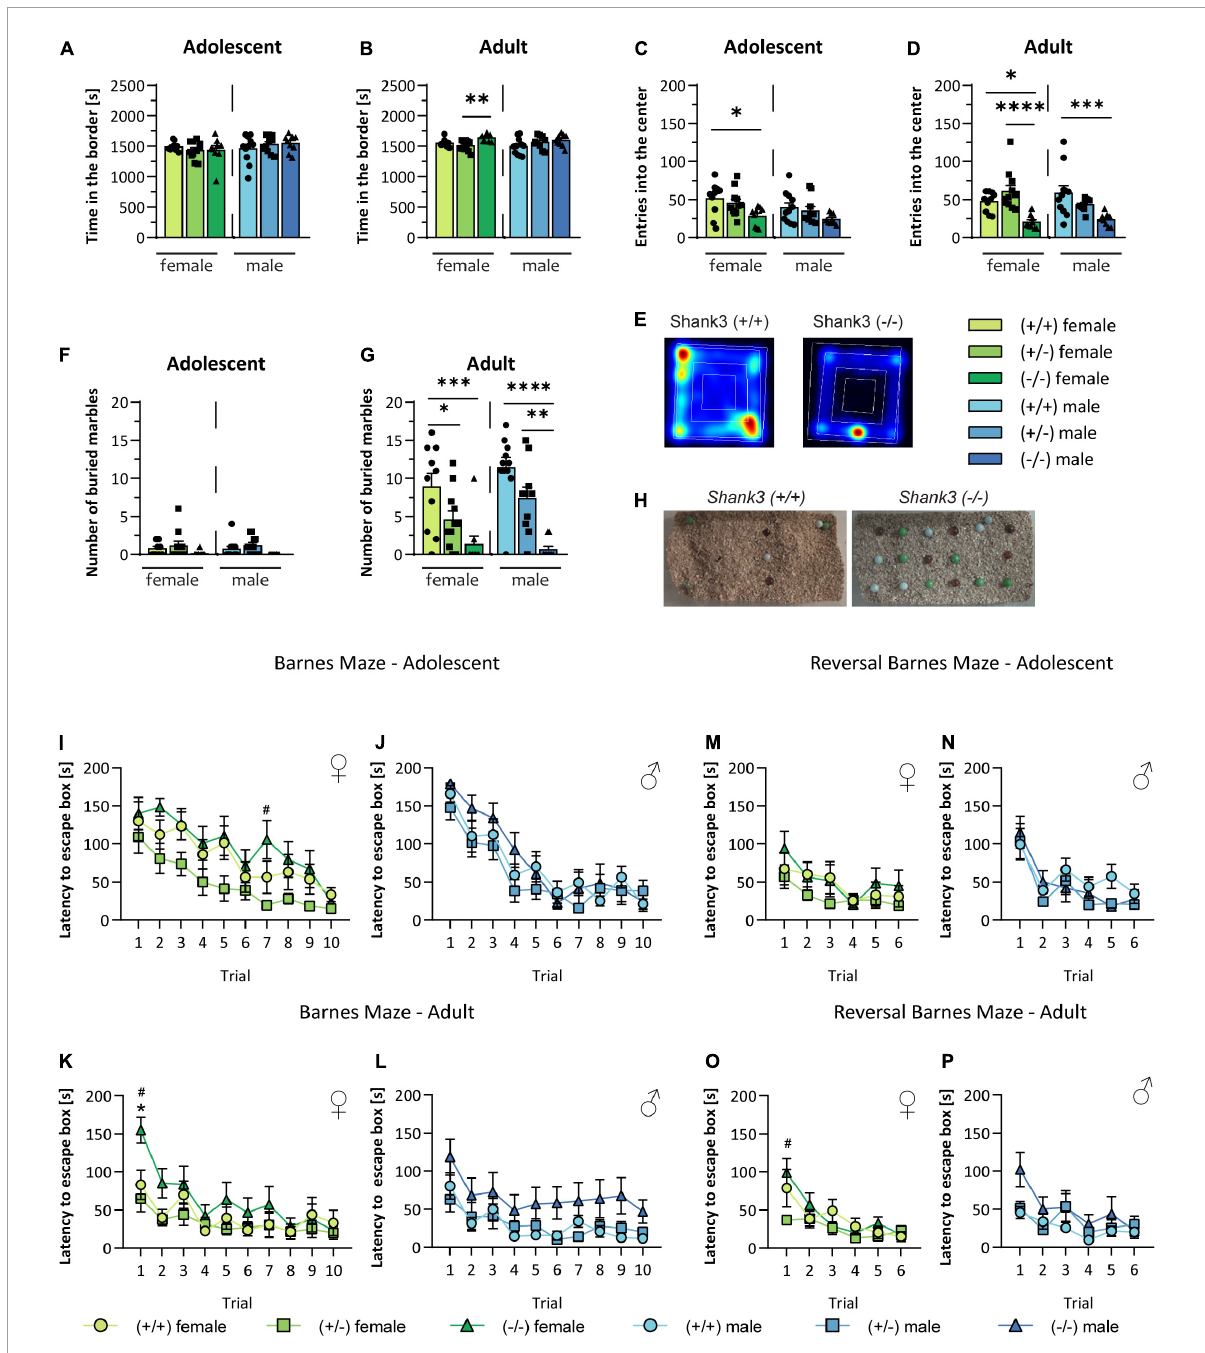
FIGURE3 Assessment of anxiety, cognitive function, and spatial learning and memory in Shank3 -transgenic mice. Anxiety of Shank3 (+/–) and Shank3 (–/–) mice compared to wildtype mice was determined in the open field test. Thereby, (A,B) the time spent in the border zone and (C,D) the number of entries into the center zone of the open field arena were determined. (E) Representative heat maps of the 30 min open field test of wildtype and Shank3 (–/–) mice are displayed. (F,G) Number of buried marbles and (H) representative images of buried marbles in the marble burying test are shown. In the Barnes Maze test, the spatial orientation and memory of the animals was tested. (I–L) The latency to enter the escape box in two trials per day on five consecutive days was analyzed, while the escape box stayed in the same position. Subsequently, the reversal Barnes Maze test was performed to determine the cognitive flexibility of the animals. Here, the position of the escape box was changed (120 to 180 ◦ ) and (M–P) the latency to enter the escape box in two trials per day on three consecutive days was determined. Asterisks ( ∗ ) indicate significant differences between wildtype and Shank3 (–/–) mice; # indicates significant differences between Shank3 (+/–) and Shank3 (–/–) mice. All data are represented as means with SEM with 9–11 animals per group. Significance levels ( p -values) are set to 0.05 ( p ≤ 0.05 ∗ / # , p ≤ 0.01 ∗∗ , p ≤ 0.001 ∗∗∗ , p ≤ 0.0001 ∗∗∗∗ ) with 95% confidence interval. See Supplementary Table 4 for detailed statistical